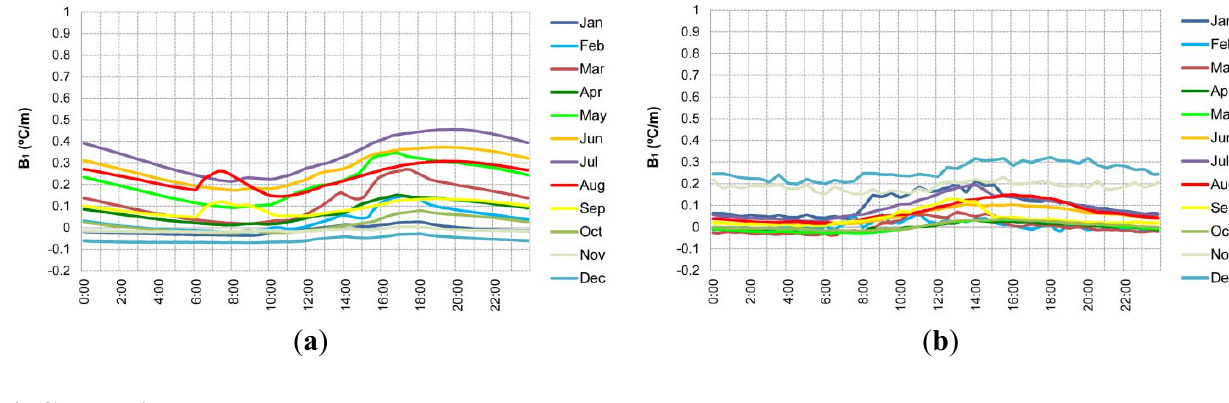
( a ) without air conditioning and ( b ) with air conditioning, measured through coefficients β Average monthly